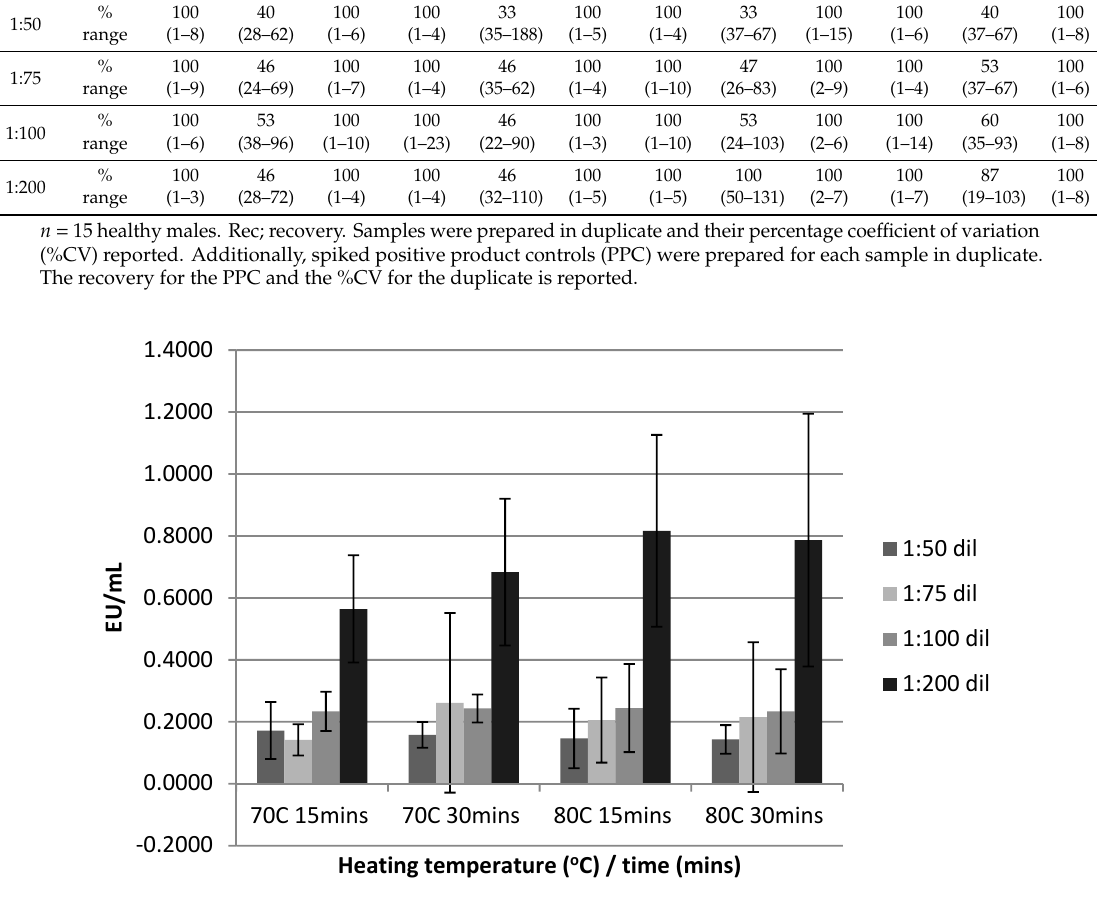
Figure 2. The effect of heat treatment, deactivation time, and dilution on serum endotoxin levels analyzed by the limulus amebocyte lysate https://en.wikipedia.org/wiki/Limulus_amebocyte_lysate (LAL) assay.